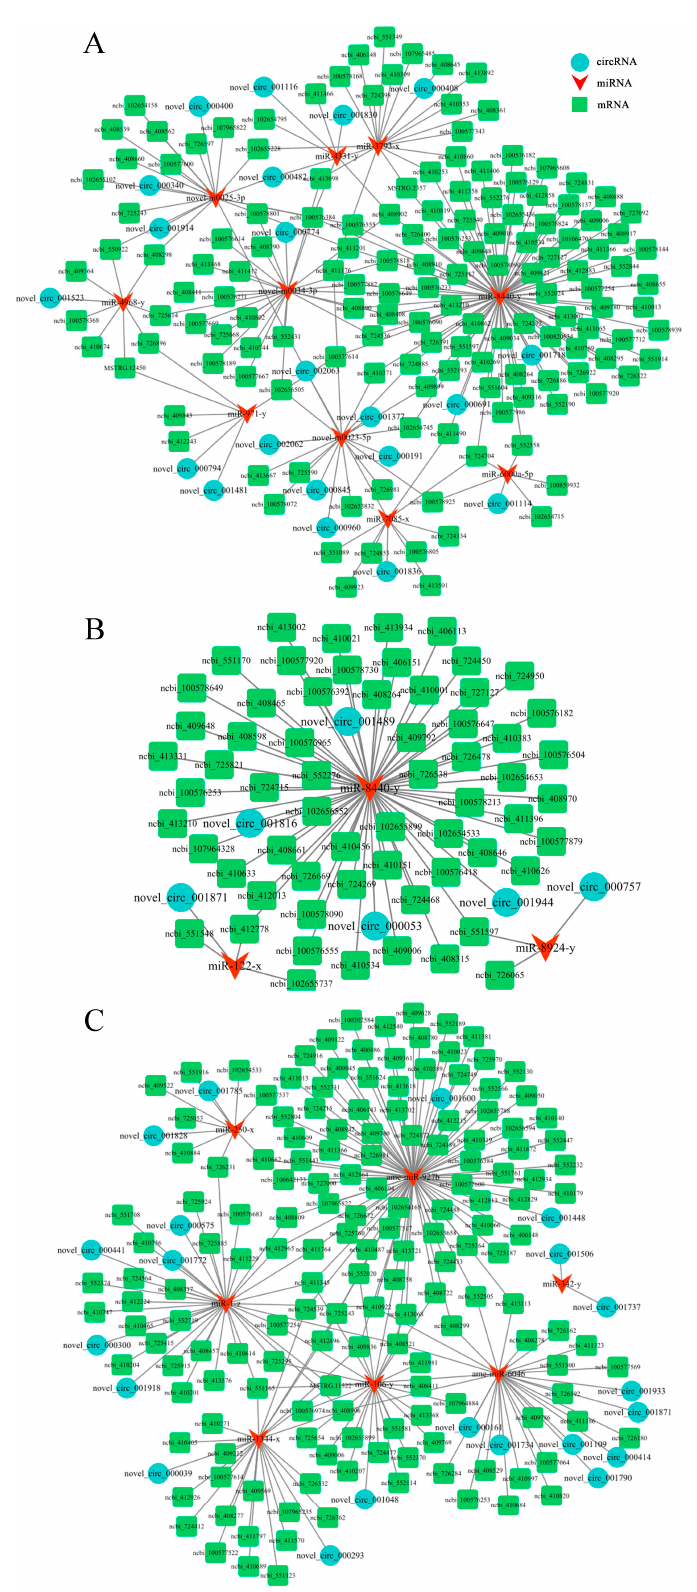
Figure 4. DEcircRNA–DEmiRNA–DEmRNA networks in ( A ) the AmCK1 vs. AmT1, ( B ) AmCK2 vs. AmT2, and ( C ) AmCK3 vs. AmT3 comparison groups.